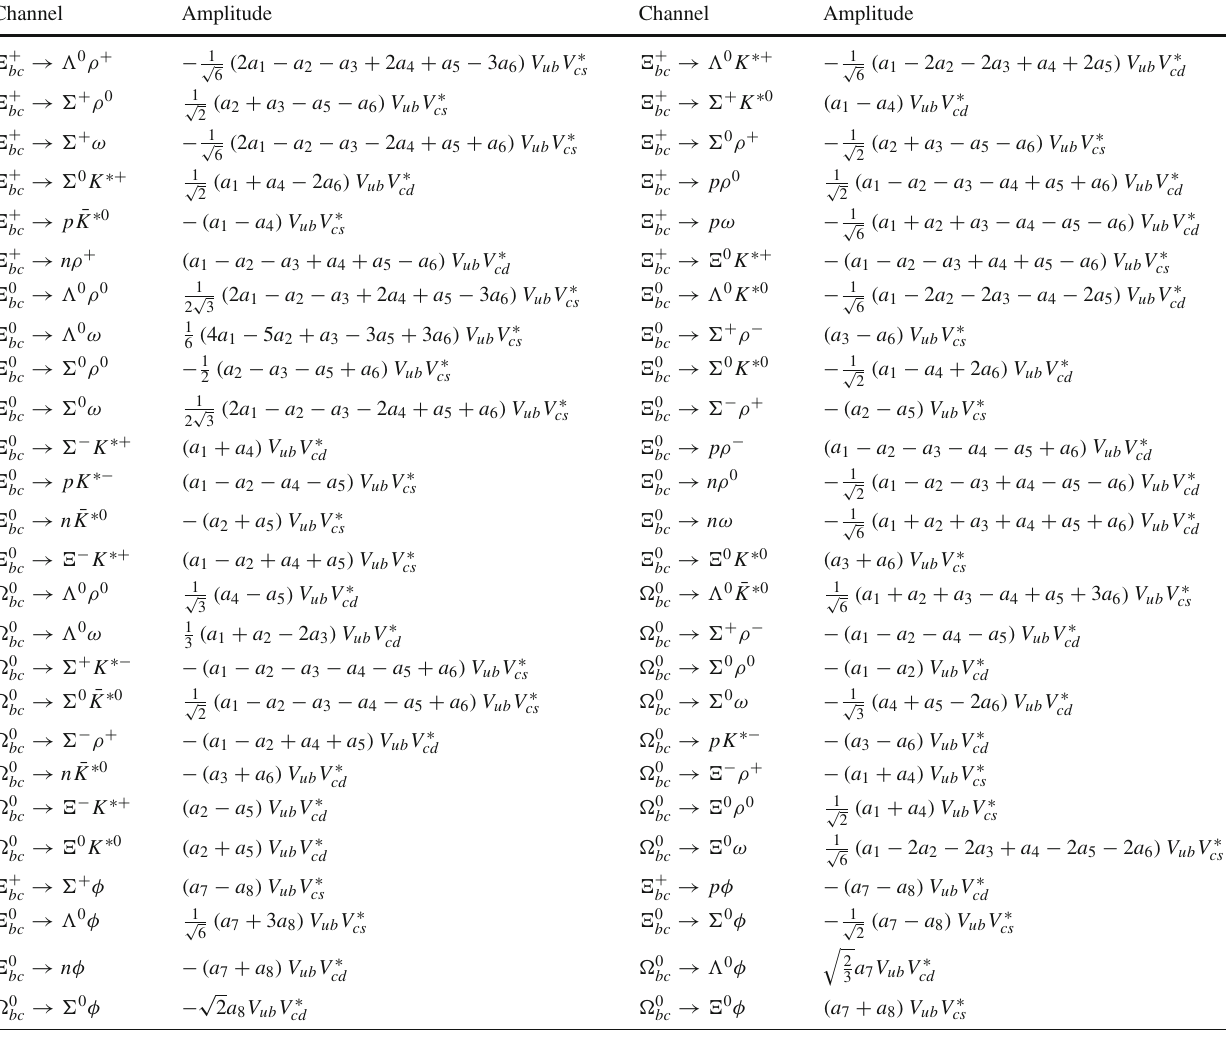
Table 2 Amplitudes for (cid:2) bc and (cid:3) bc decays into a light baryon (octet) and light vector meson Channel Amplitude Channel Amplitude (cid:2) + → (cid:4) 0 ρ bc